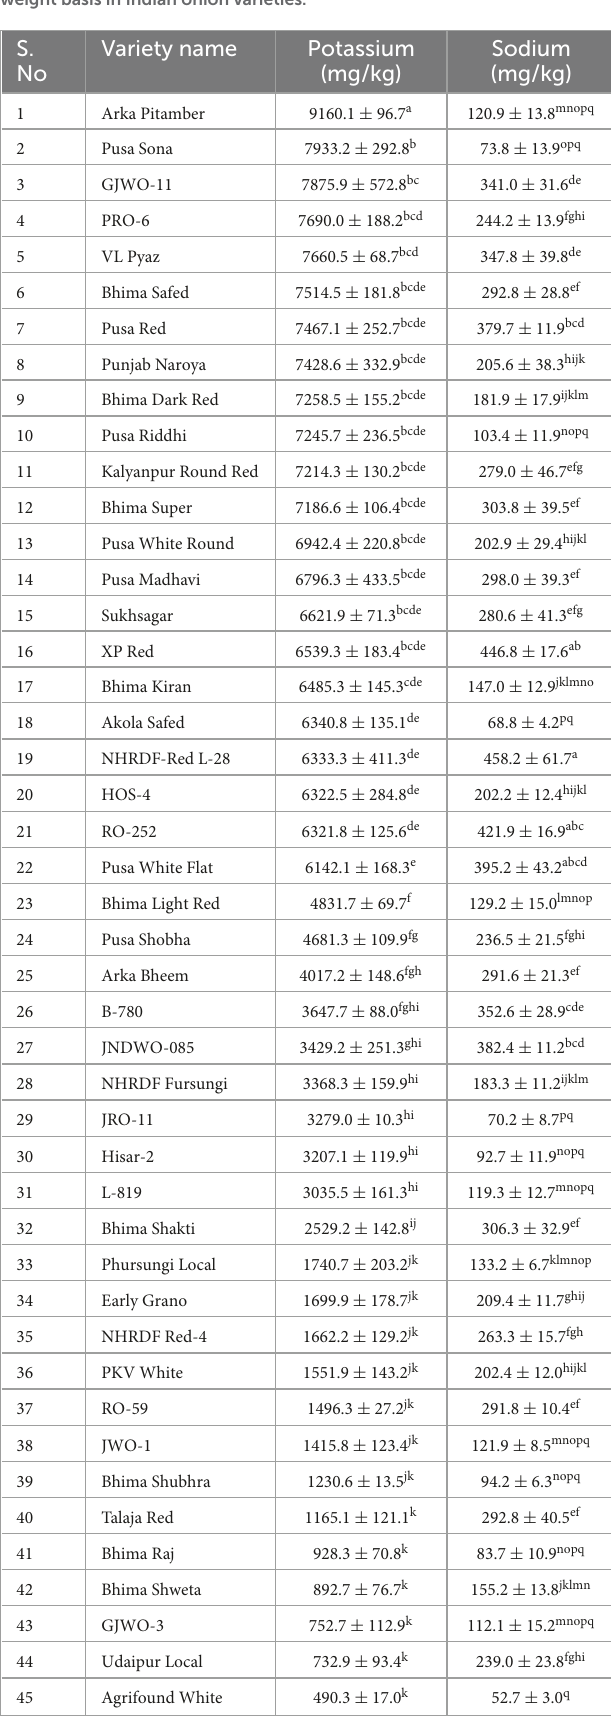
TABLE 3 Estimation of potassium (K) and sodium (Na) of fresh bulbs on dry weight basis in Indian onion varieties. S.